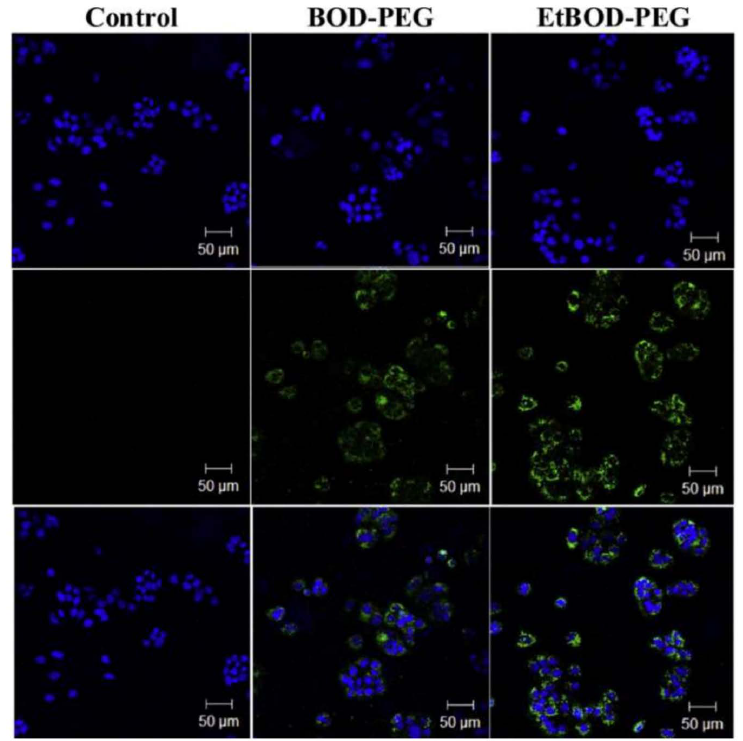
Figure 7. CLSM images of MCF-7 cells with BODIPY-PEG 24 or Et-BODIPY-PEG 25 at various concentrations, with the nucleus labeled with 4 (cid:48) ,6-diamidino-2-phenylindole (DAPI). Top: DAPI im- ages; middle: BODIPY-PEG/Et-BODIPY-PEG dye images; bottom: merged images of both (10.0 µ M). Adapted from